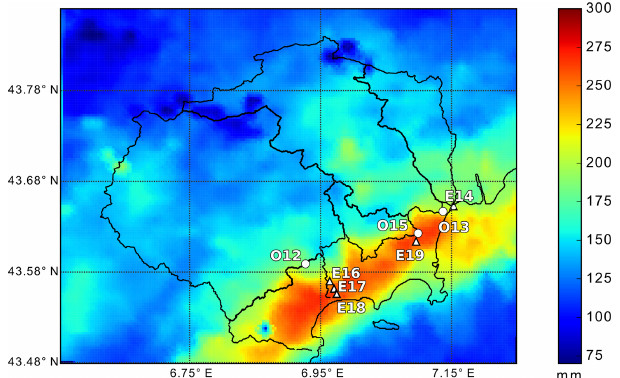
Figure 6. Cumulated rainfall over zone B during the October 2015 event for the Pégomas (O12), Villeneuve-Loubet (O13), Biot (O15), and Cannes (E18)